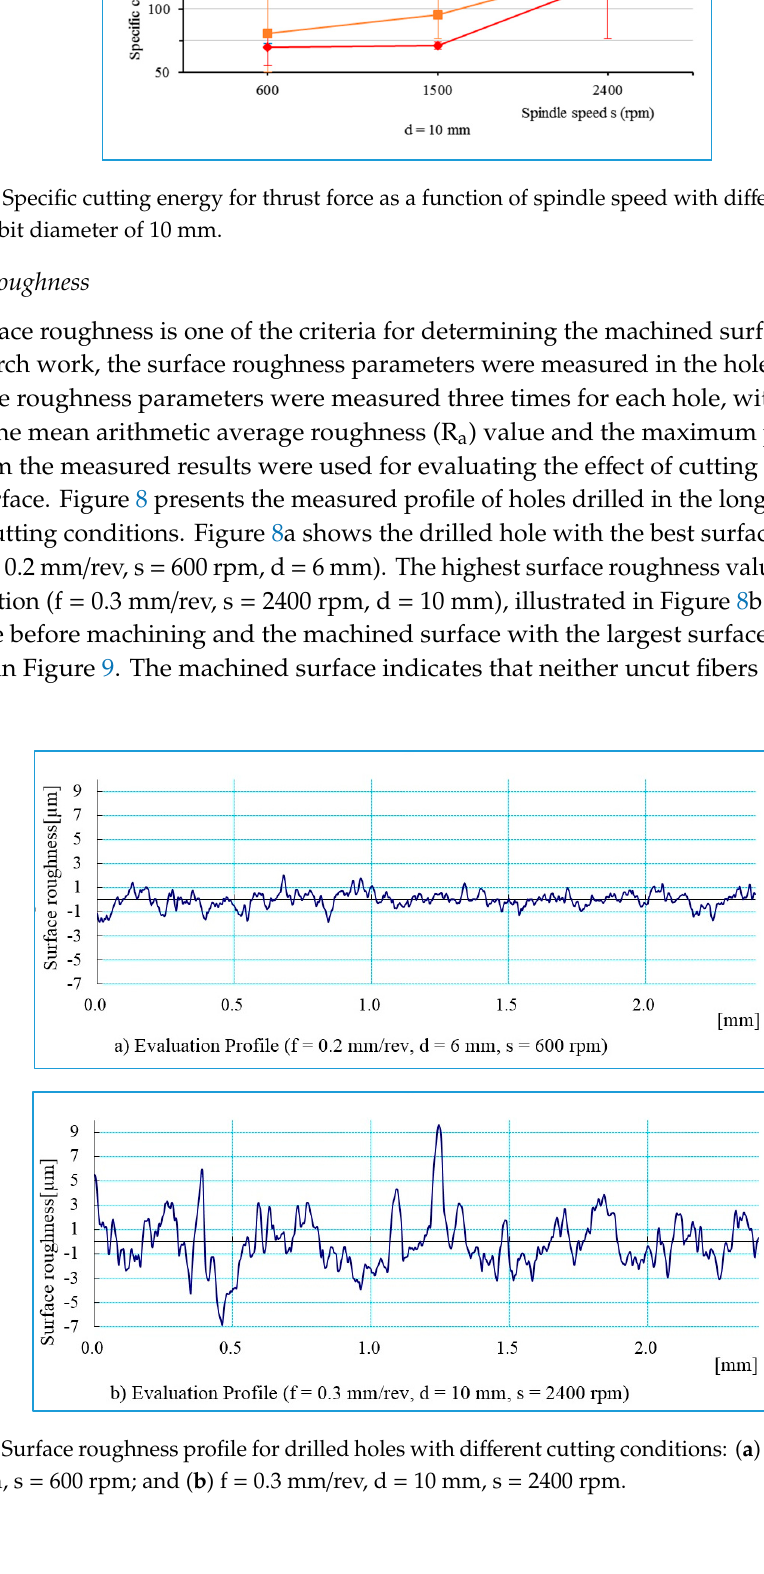
Figure 6. Main effects plot for specific cutting energy related to thrust force.